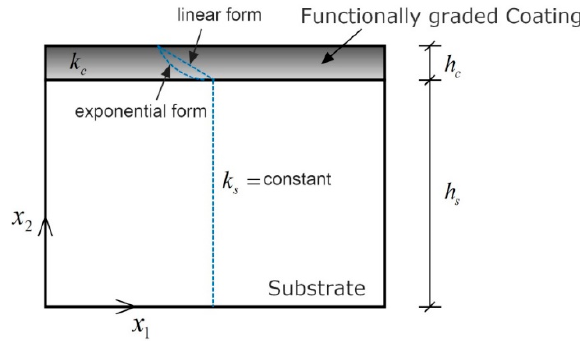
Figure 1. Configuration of the functionally graded coating/substrate system.